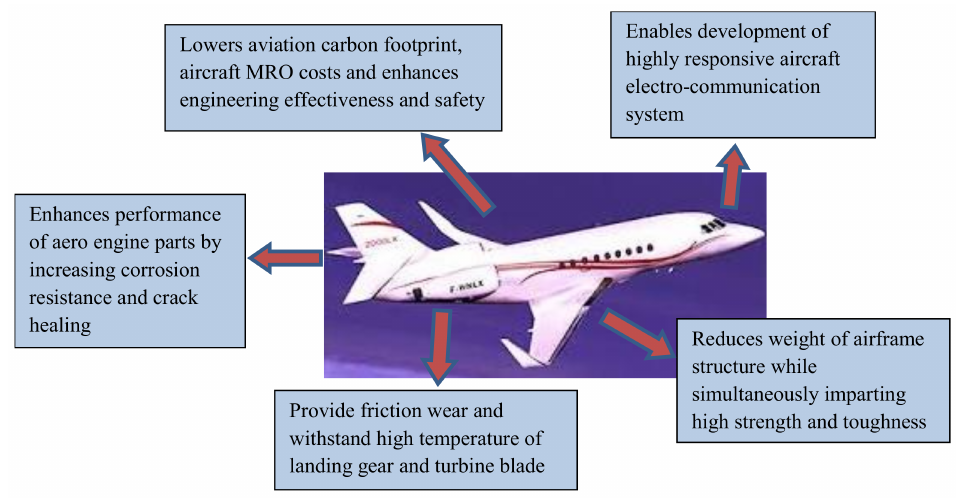
Figure 3. Benefits from nanocoatings for aerospace materials